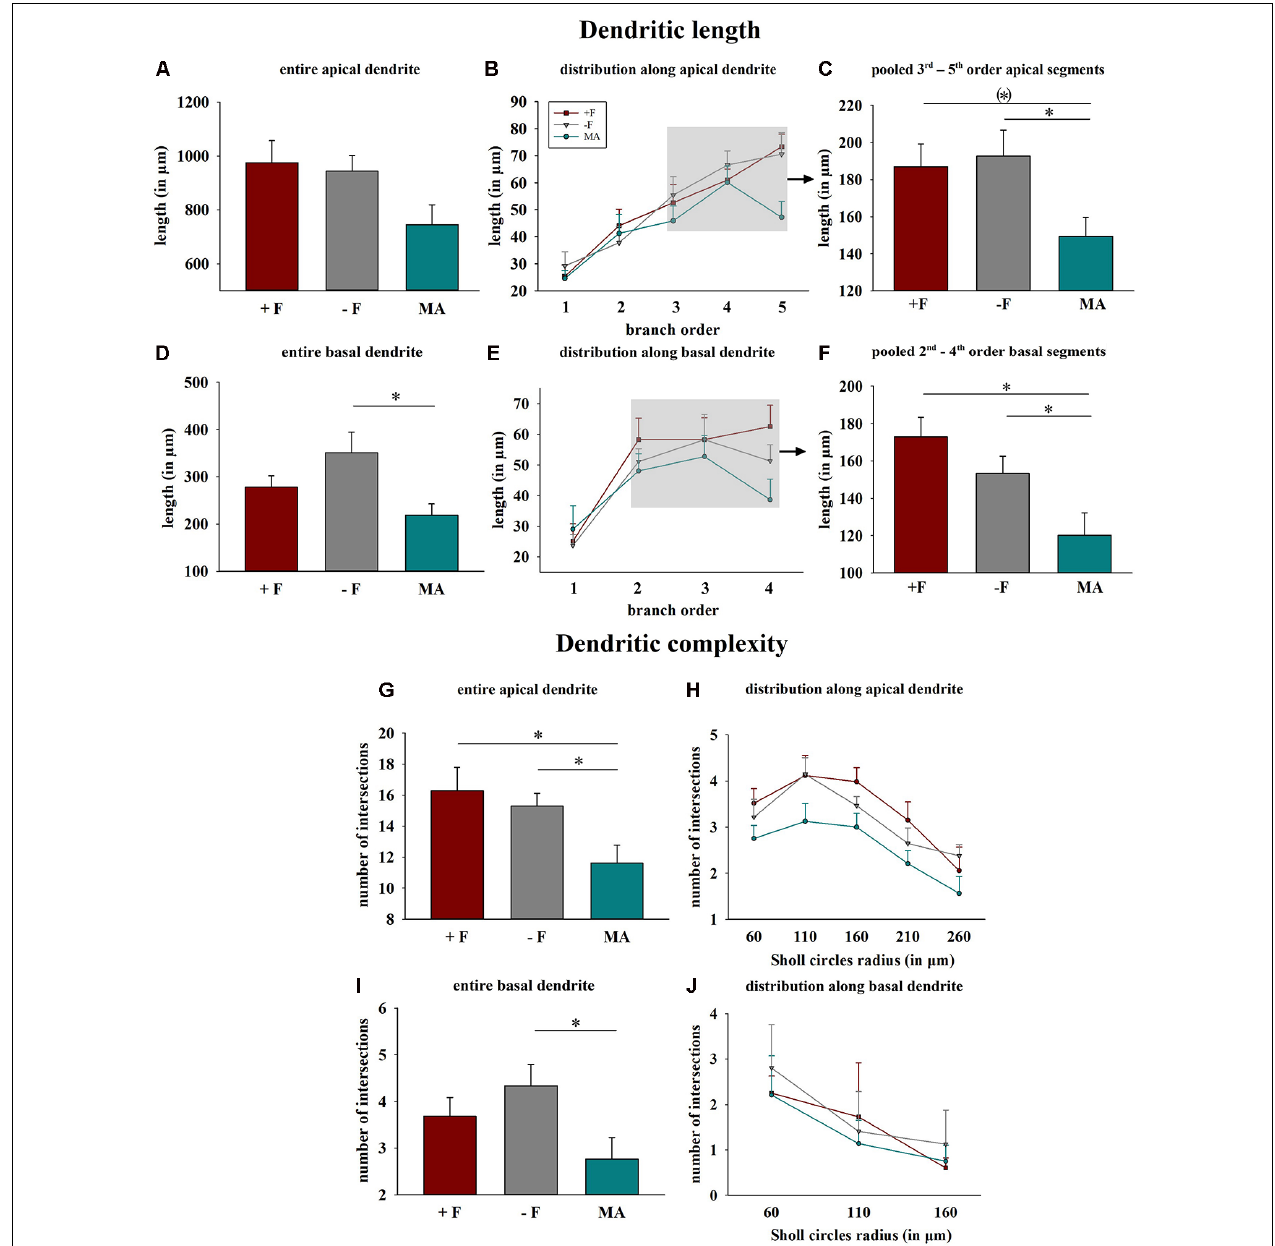
FIGURE 4 | Effects of different rearing conditions on dendritic length and complexity in female degu offspring. (A,D) Dendritic length for entire apical (A) or basal (D) dendrites. (B,E) Distribution of mean dendritic length within the individual dendritic segments (branch orders) along apical and basal dendrites; rectangles in figures in the central column indicate the branch orders used for pooled segment analysis. (C,F) Dendritic length of the pooled 3rd to 5th branch order segments in apical and the 2nd to 4th branch order segments in basal dendrites. (G,H,I,J) Dendritic complexity indicated as intersections as a result of Sholl analysis; (G,I) sum across entire apical or basal dendrites, (H,J) distribution along apical and basal dendrites. +F, male and female biparental control group; − F, fatherless single mother group; MA, female biparental (mother and aunt) group. ∗ p ≤ 0.05, ( ∗ ) p ≤ 0.1, SNK post hoc test.